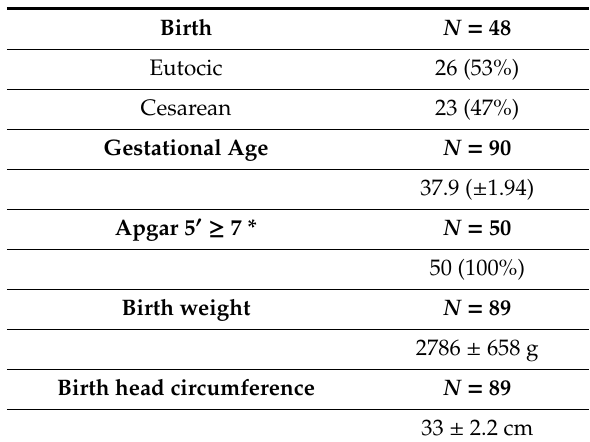
Table 1. Baseline